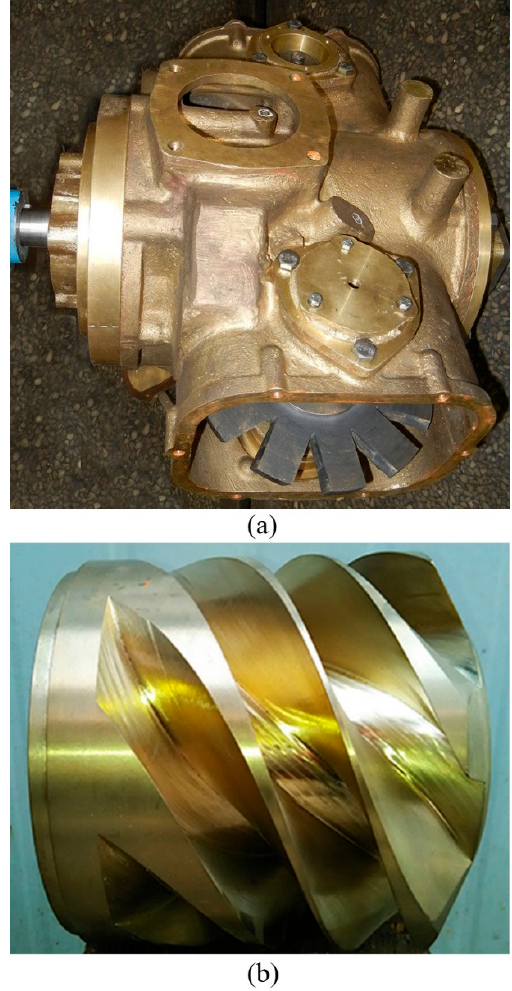
Figure 4. The fabricated SSC: ( a ) casing and gate-rotor; ( b ) screw rotor.